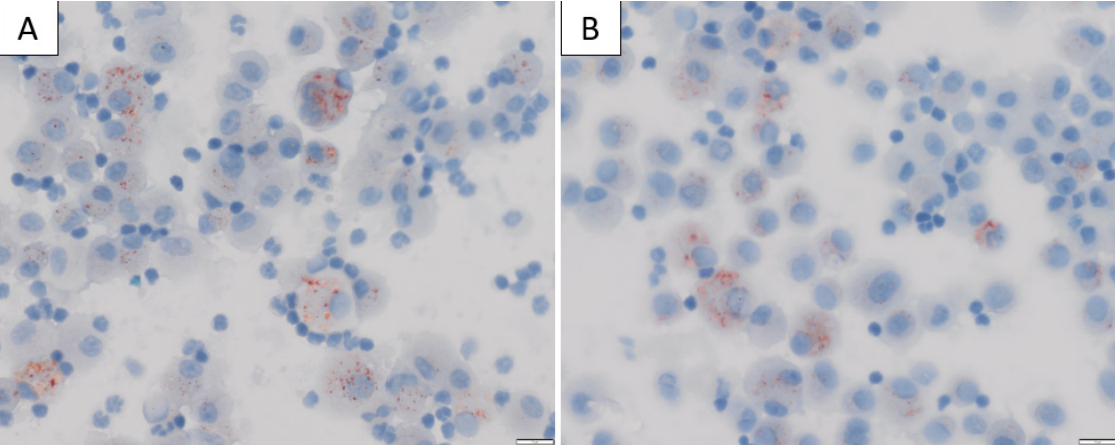
Figure 3. ( A , B ) Bronchoalveolar lavage (BAL) cytology from a patient diagnosed with EVALI in our institution, stained with Oil-Red-O × 400 magnification showing positive red intracytoplasmic droplets in the alveolar macrophages, consistent with excess neutral lipid.